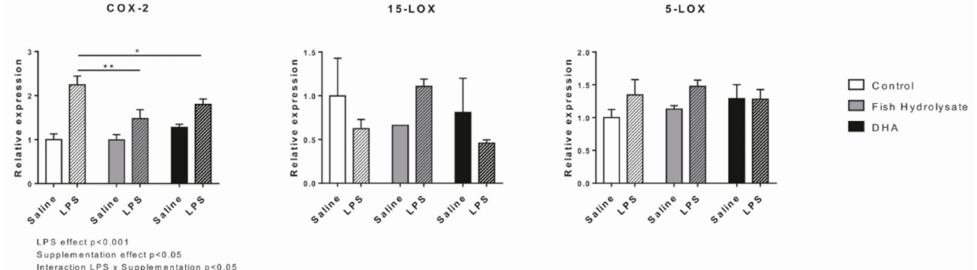
Figure 7. Expression of oxylipin biosynthesis enzymes (COX-2, 15-LOX and 5-LOX) in the hippocampus of mice fed orally with control solution, fish hydrolysate or DHA by daily gavage for 18 days, 2 h following LPS injection (125 µ g/kg) (* p < 0.05, ** p < 0.01 by 2-way ANOVA and Fisher’s LSD post hoc test; n = 4–6 per group). Data are presented as mean ± SEM. DHA: docosahexaenoic acid; LPS: